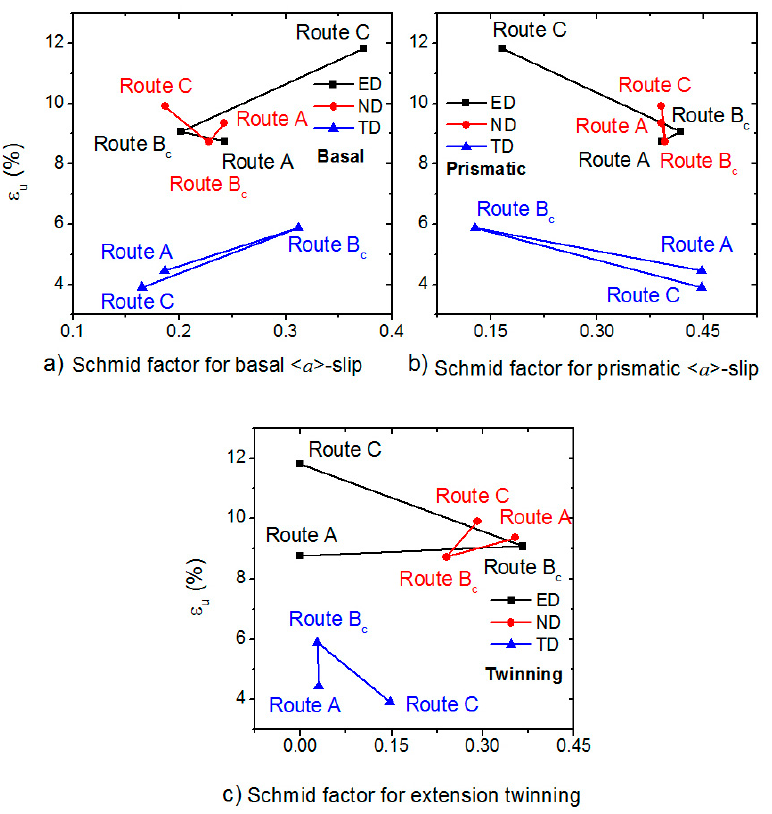
Figure 8. Dependence of the uniform elongation on the Schmid factor for ( a ) the basal < a >-slip, ( b ) the prismatic < a >-slip and ( c ) extension twinning.